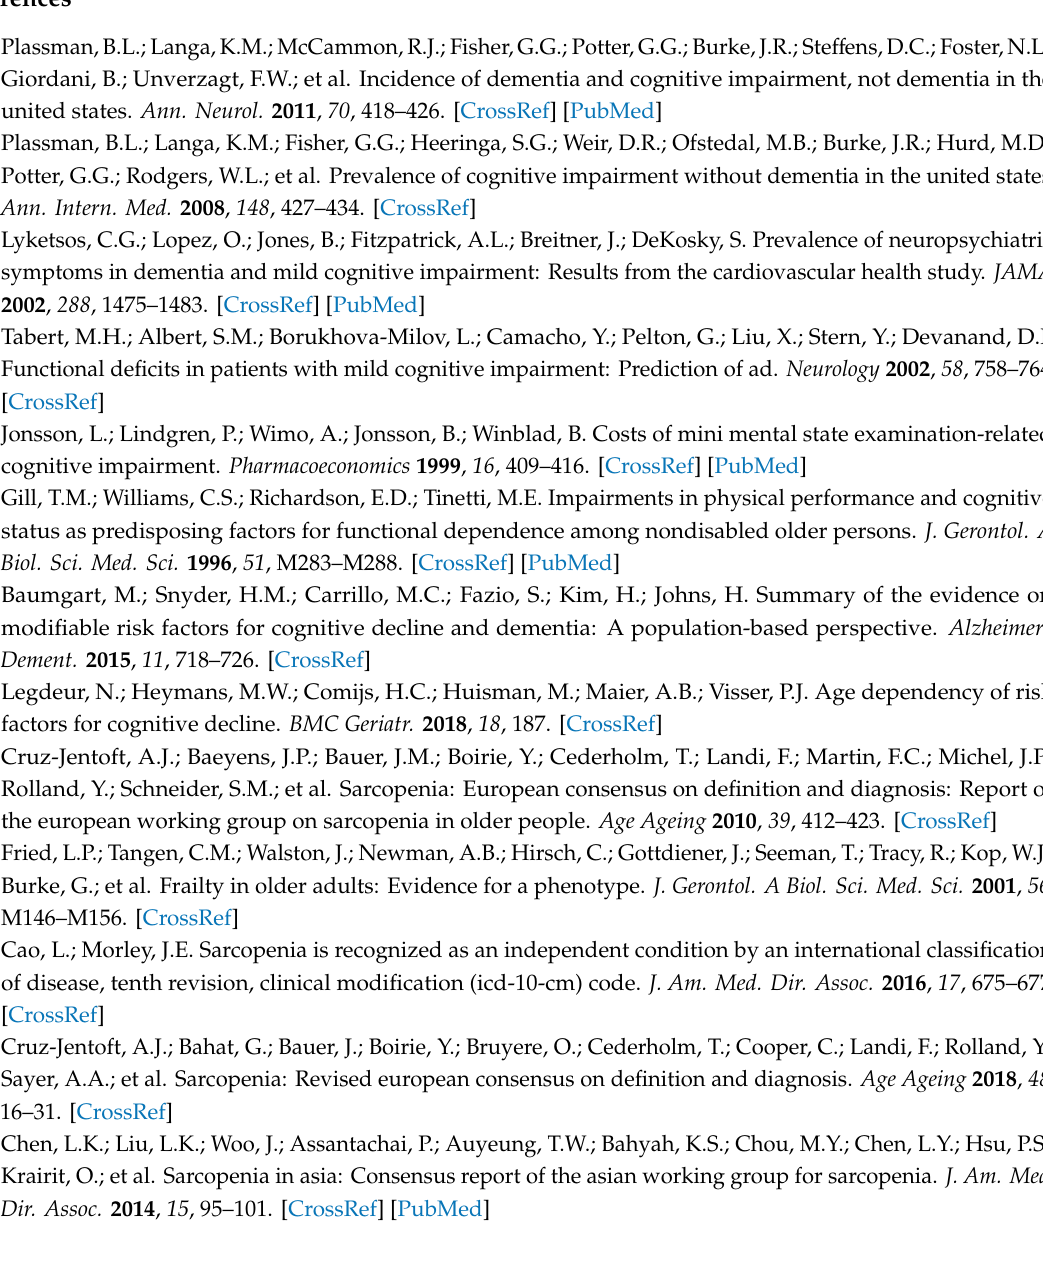
Table S1. Associations of body composition index, muscle strength, and muscle function with neuropsychological test